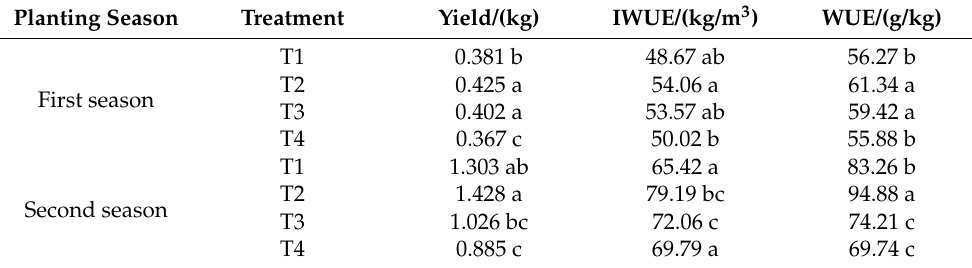
Table 6. Analysis of lettuce weight and water use efficiency under different water treatments. Planting Season Treatment Yield/(kg) IWUE/(kg/m 3